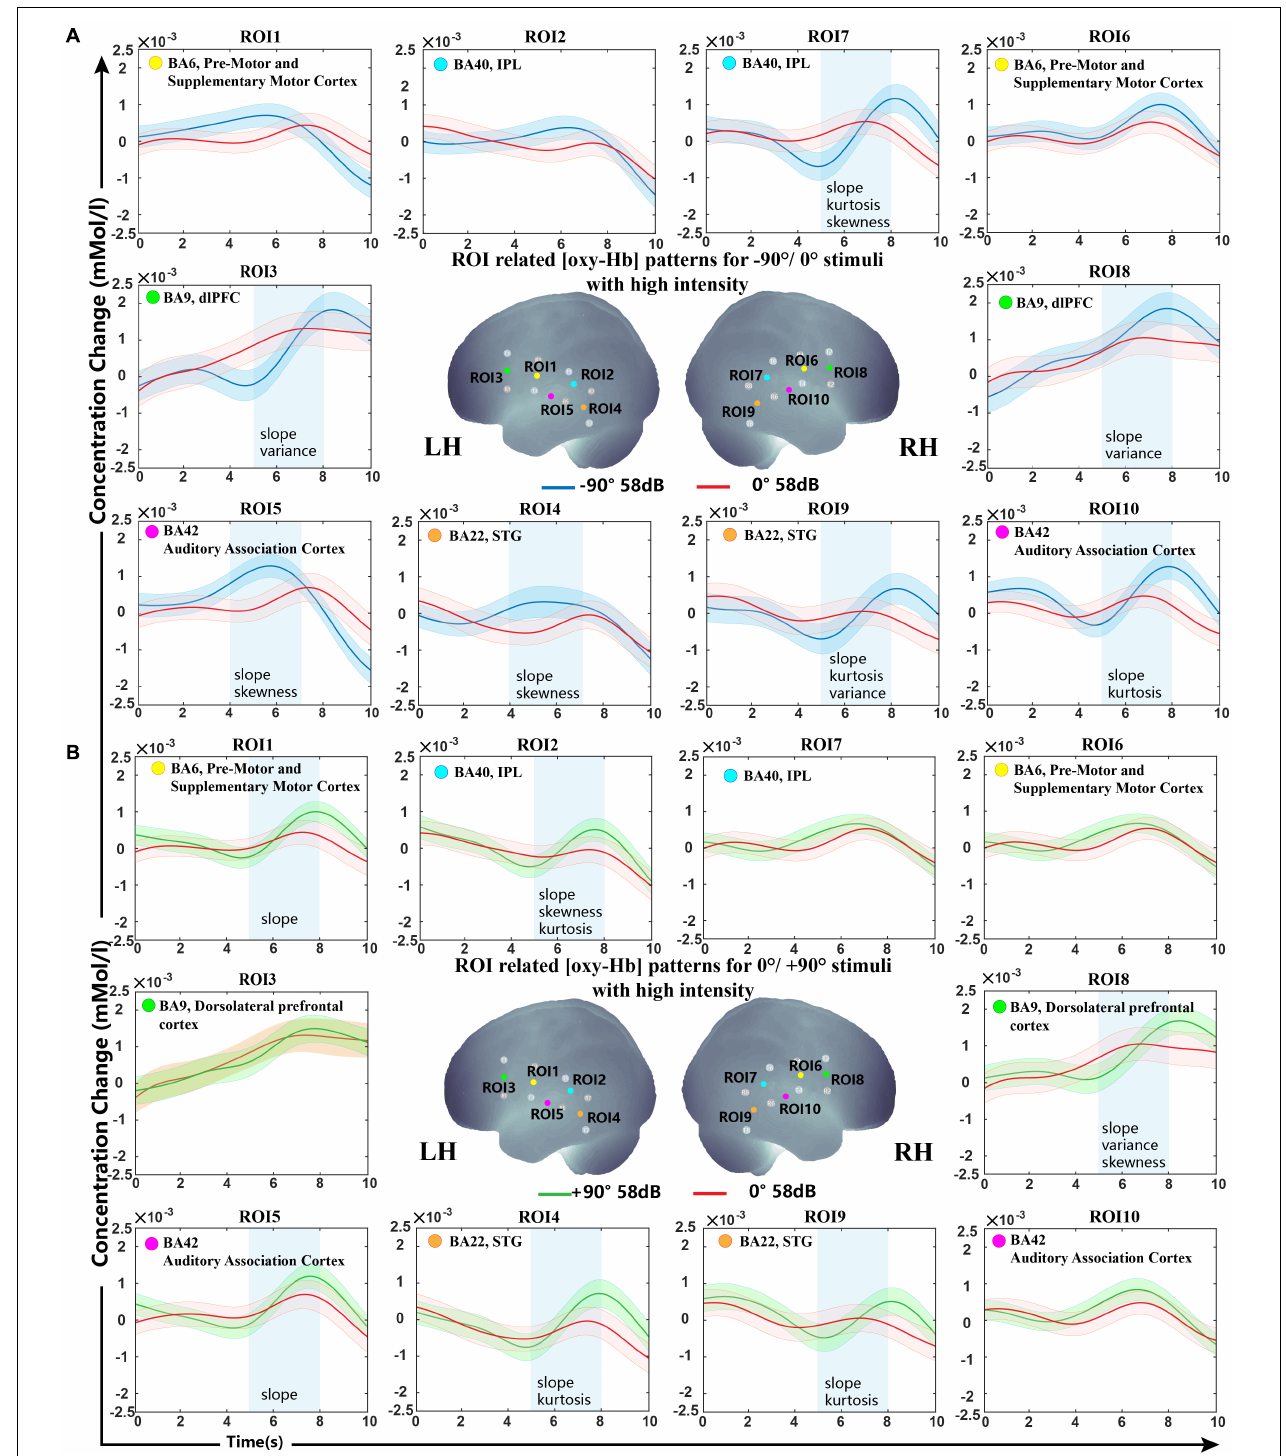
FIGURE 2 | Grand-averaged [oxy-Hb] responses recorded from different locations in high sound intensity (58 dB) for all ROIs and the optimal selected feature set. (A) Sound sources from − 90 ◦ and 0 ◦ . (B) Sound sources from +90 ◦ and 0 ◦ . The stimuli were presented at 0 s, and all subjects started concentrating on the sound source. The anatomical location diagram of 10 ROIs is shown in the center of the figure. The lines in blue, red, and green represent the sound sources from − 90 ◦ /0 ◦ /+90 ◦ . The selected ROIs with optimal analysis time periods (blue rectangles) and features (shown on the bottom of the blue rectangle) are presented. The shaded regions indicate the standard errors computed across all subjects for the relative